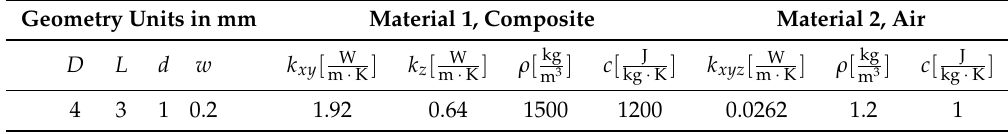
Table 1. Simulation parameters for the numerical solution of the heat equation.